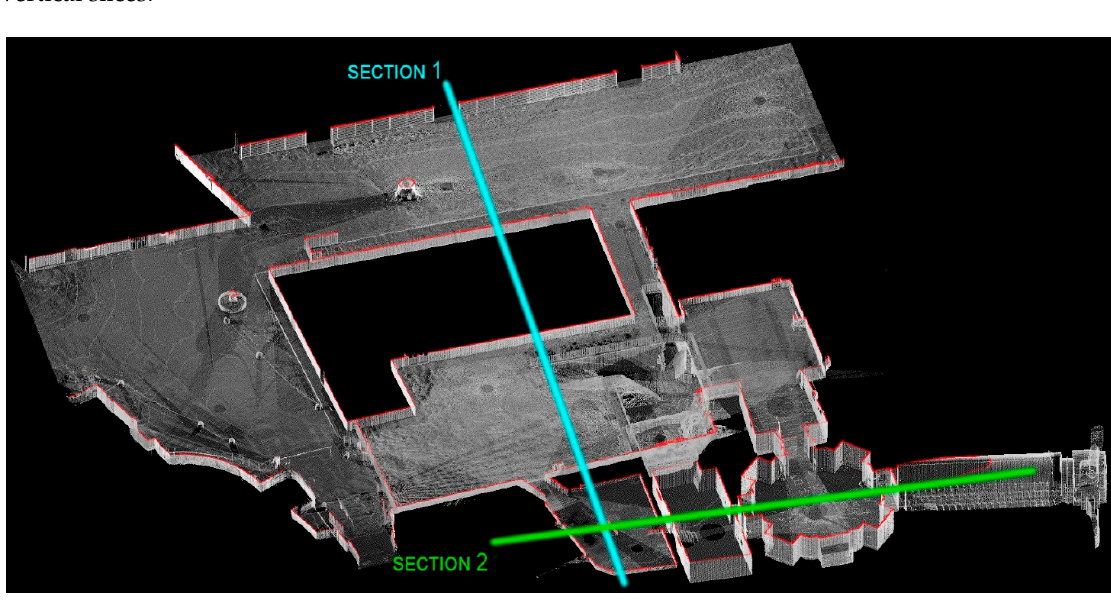
Figure 3. Path 1, reference dataset. Slice extraction: one horizontal (red) at 1.35 m above floor level, and two vertical, one with indoor/outdoor spaces (Section 1, cyan) and one indoor only (Section 2, green).